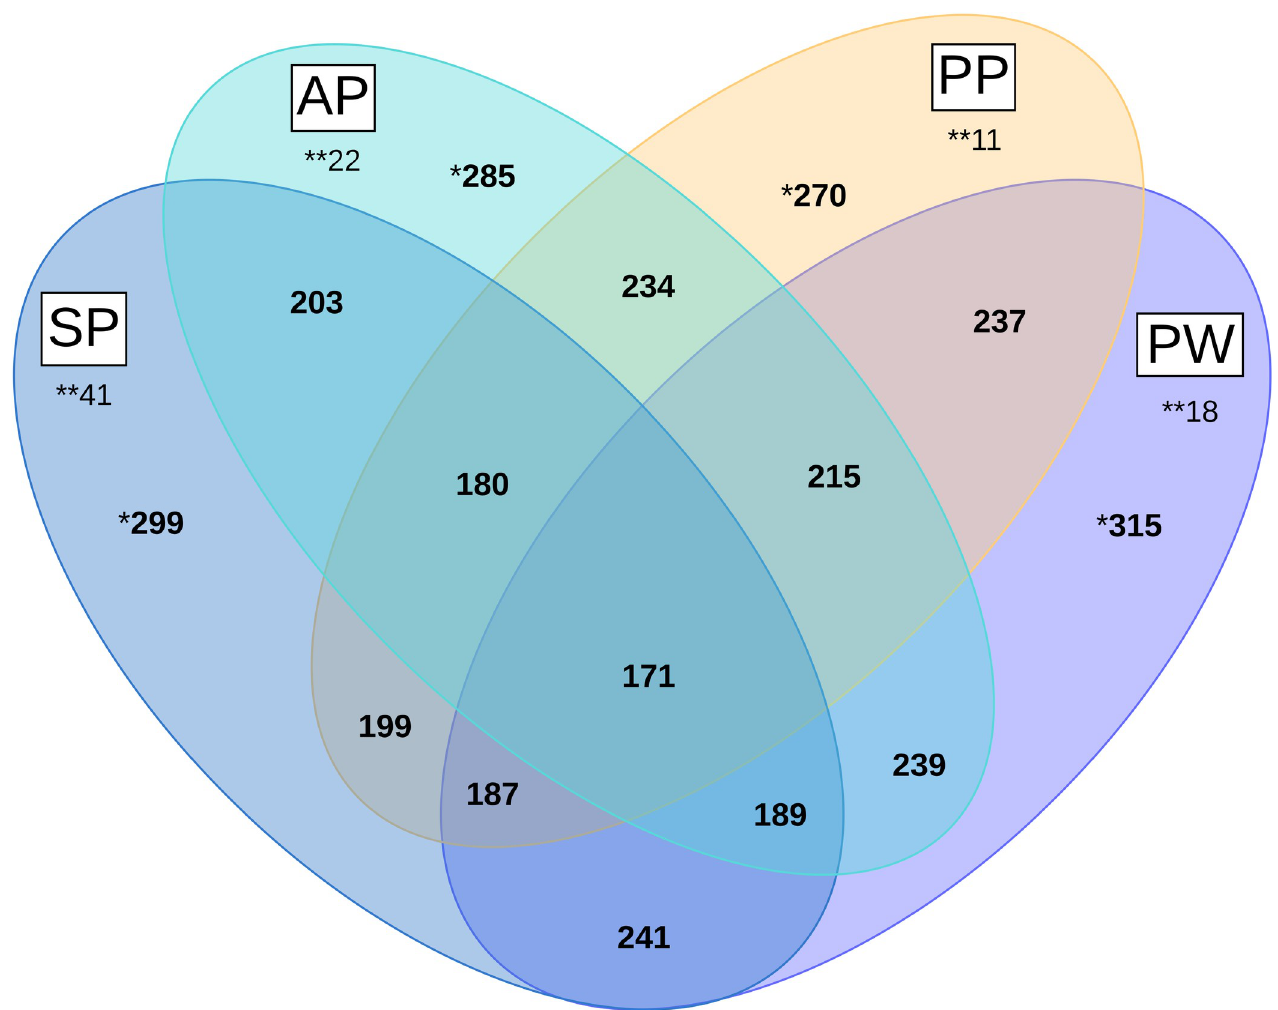
Fig 1. Venn diagram of genus distribution between different groups of animals. AP = Sows antepartum, PP = sows postpartum, SP = suckling piglets, PW = post-weaning piglets, � Total number of genera; �� Number of unshared genera.